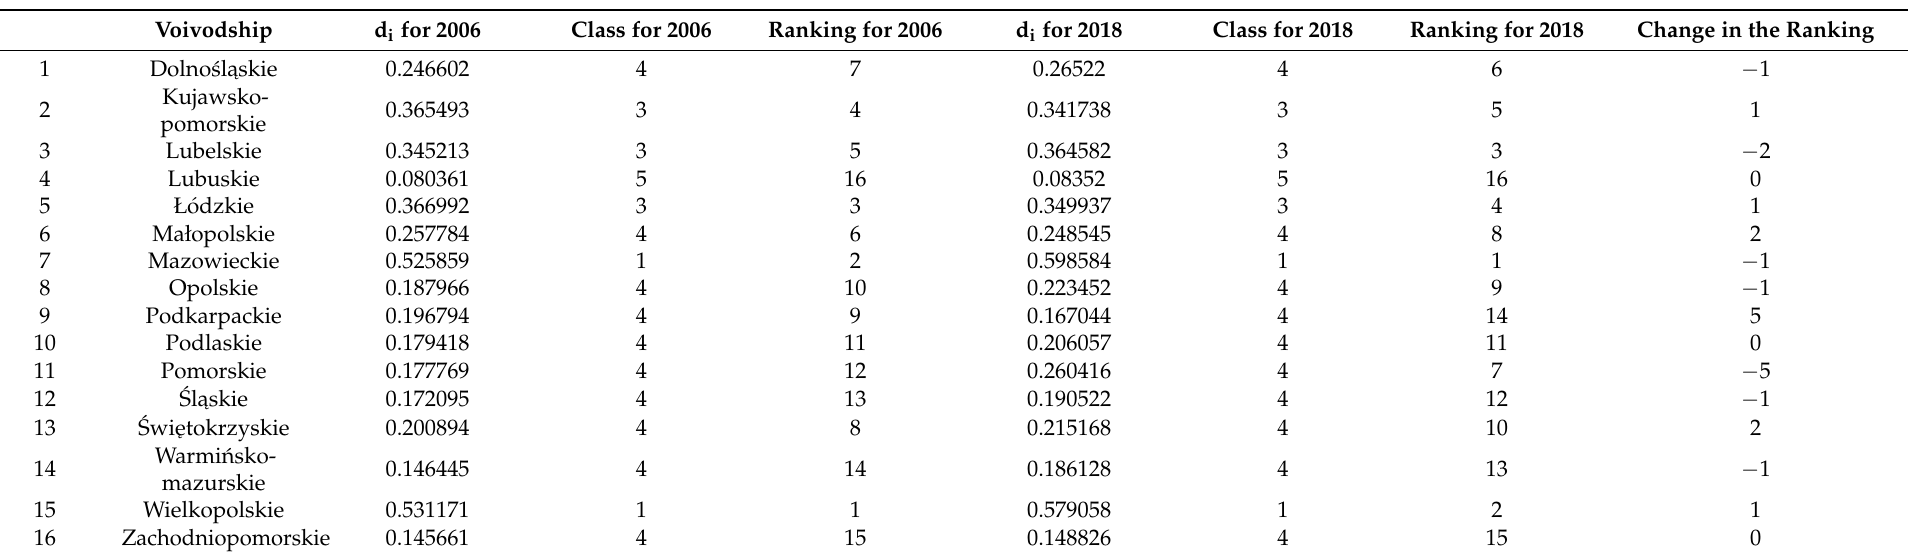
Table 4. Results of the